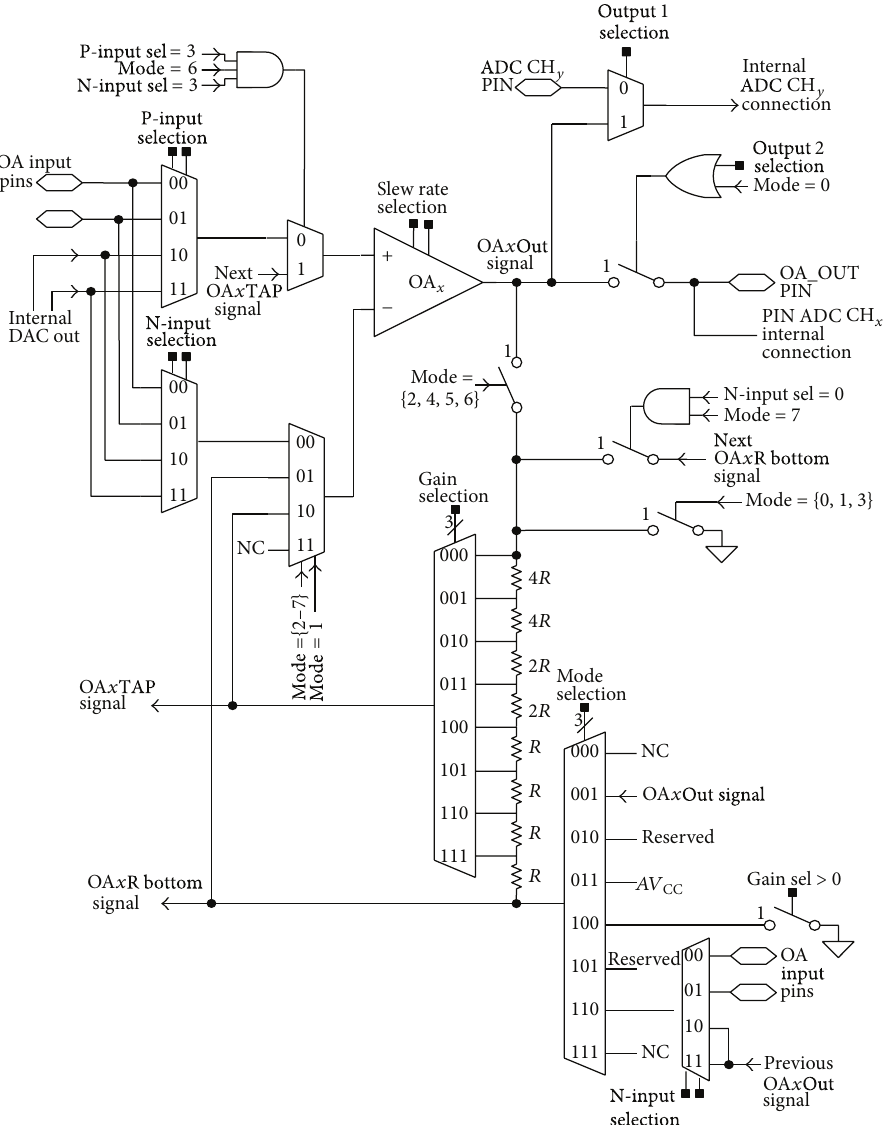
Figure 4: Schematic diagram of an OA